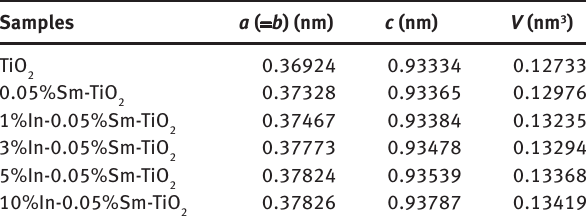
Table 1: Lattice parameters of x In-0.05%Sm-TiO Samples